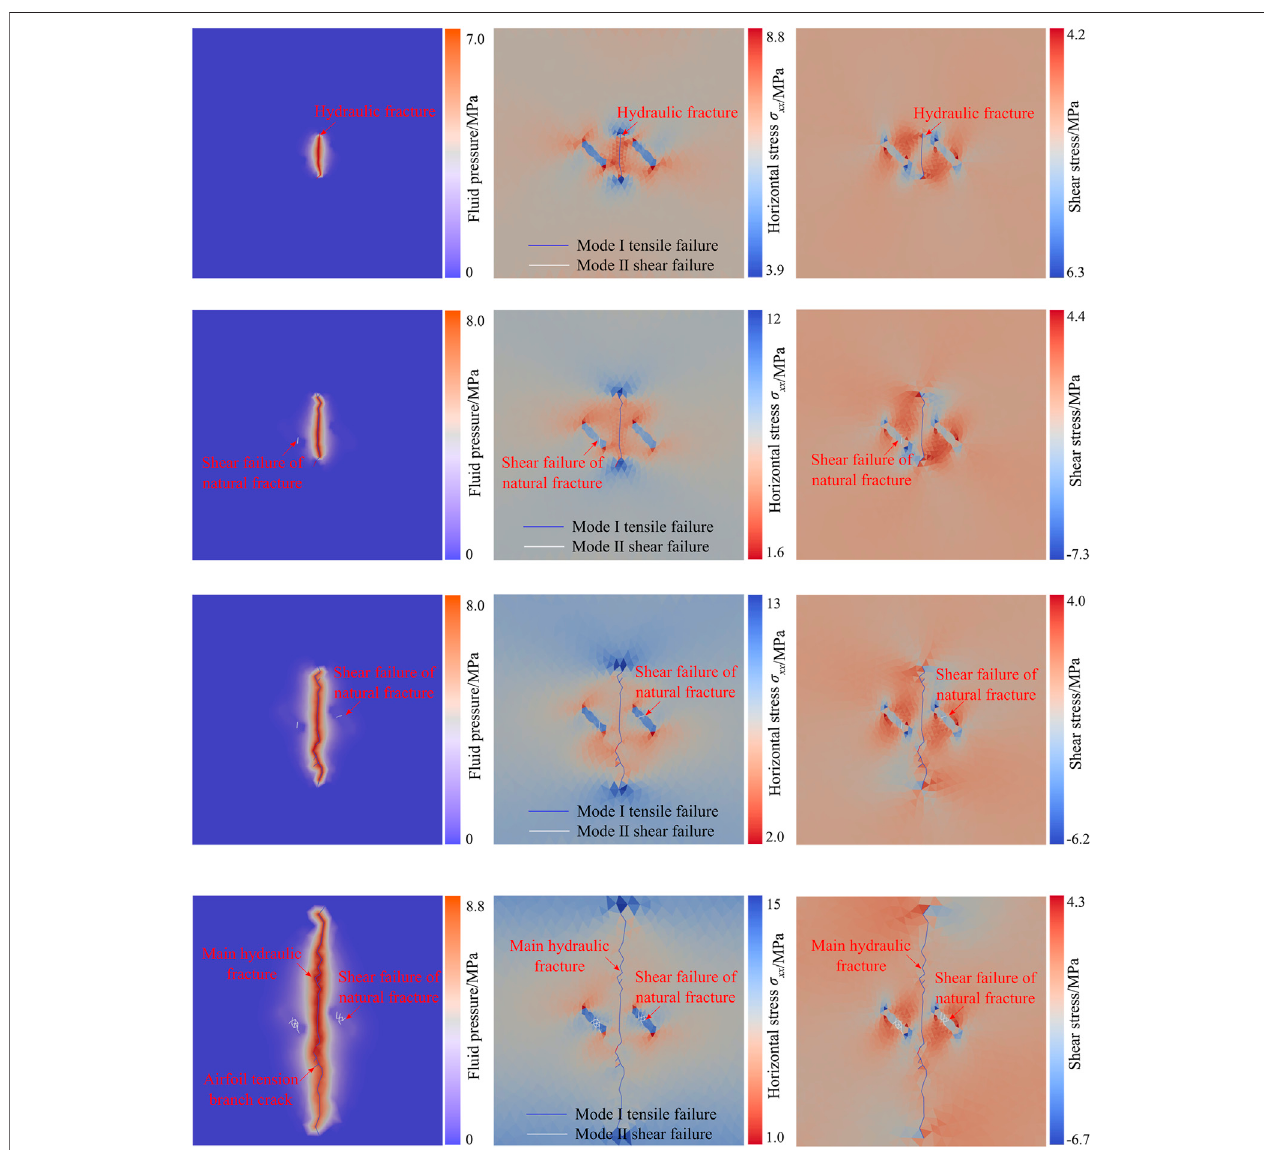
FIGURE 13 | The fracturing process of natural fracture and distribution of fl uid pressure, horizontal stress, and shearing stress during hydraulic fractures propagation. (A) t (cid:2) 0.645 s; (B) t (cid:2) 1.075 s; (C) t (cid:2) 1.892 s; (D) t (cid:2) 3.591 s.